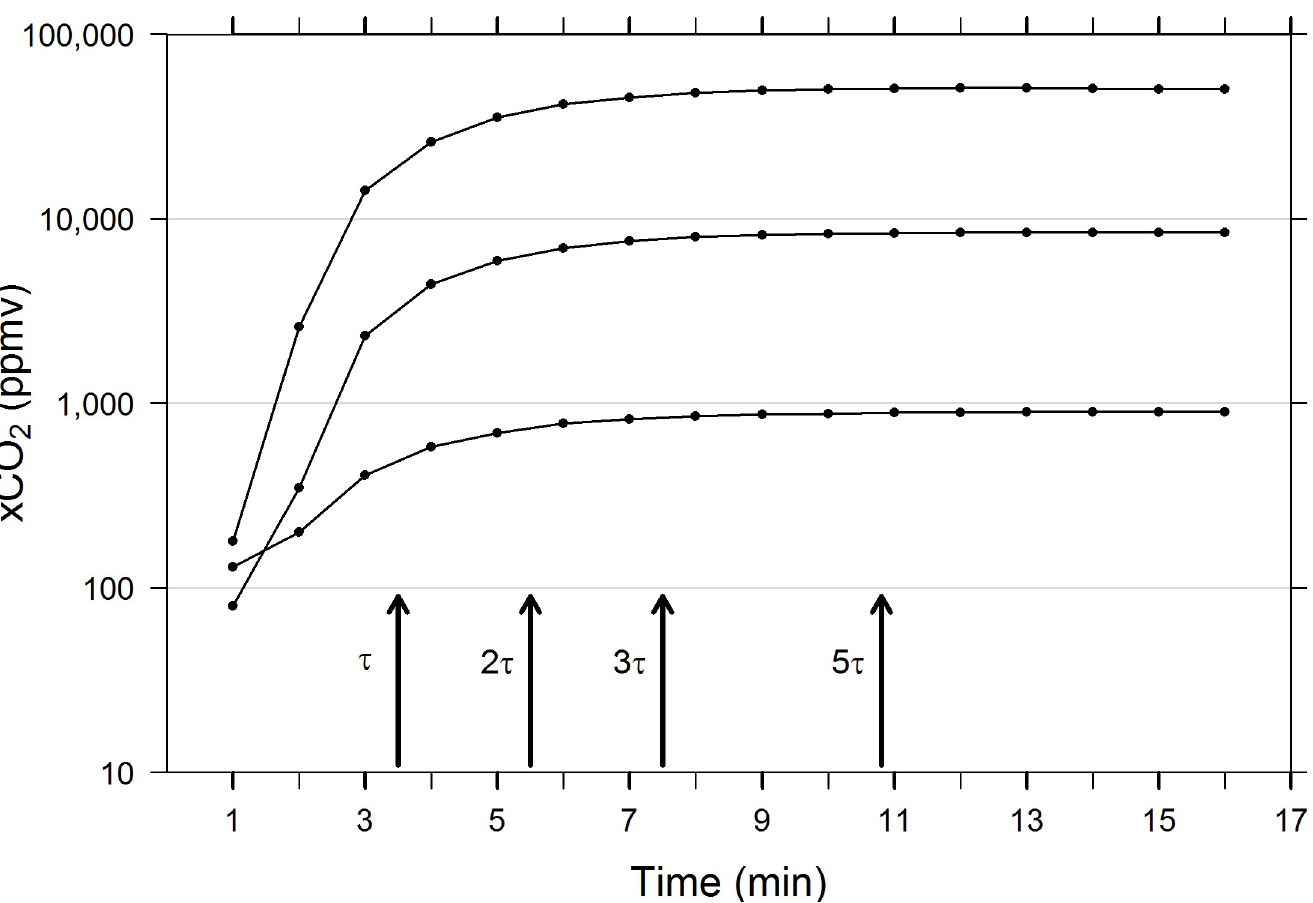
Fig 8. Results from three low to high concentration equilibration trials. Multiples of τ (mins) correspond to 63.2%, 86.5%, 95.0%, 99.3% of maximum values measured. Arrows indicate mean τ values for all three trials (see Table 1 for summary of mean and standard deviation values). Concentrations are plotted on a log scale to better visualize low and high